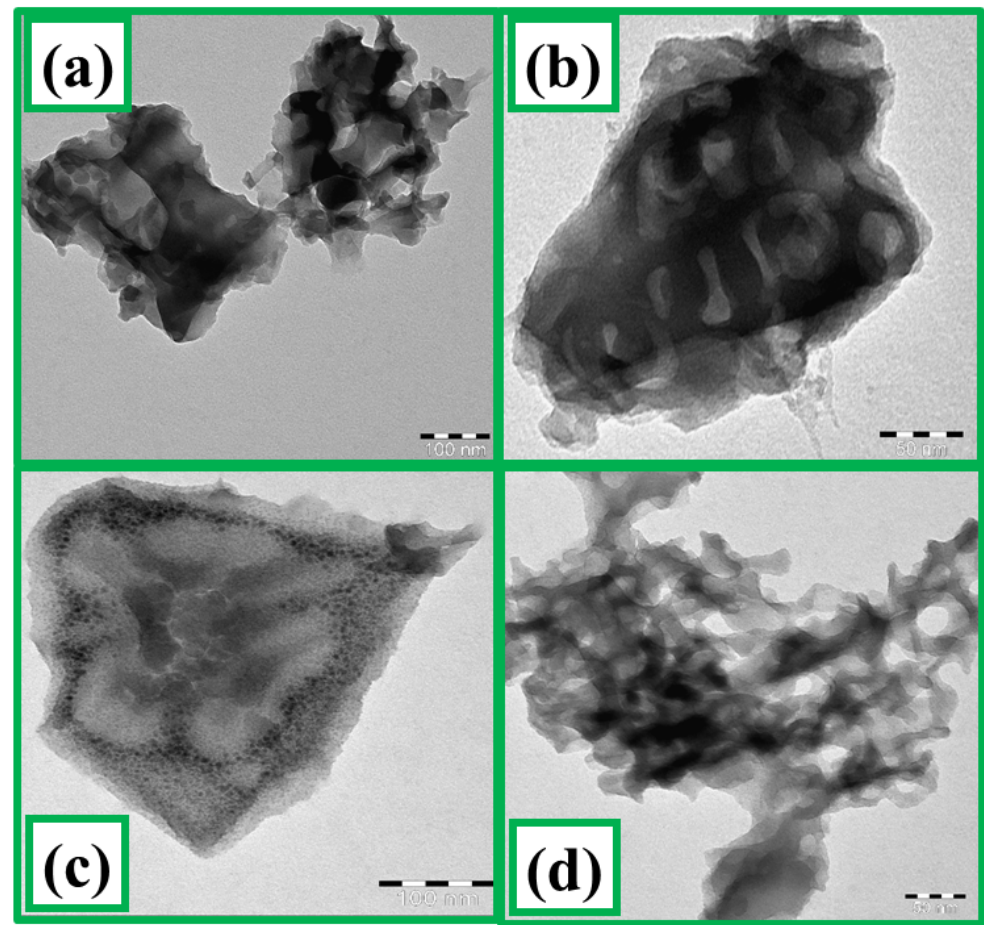
Figure 5. Low and high magnification TEM images of the Zn-U1 ( a , b ) and Zn-U3 ( c , d ) nanocomposites.